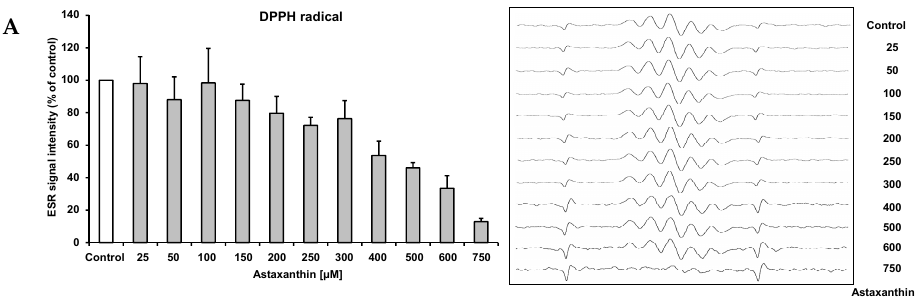
Figure 2. Cont. Figure 2.